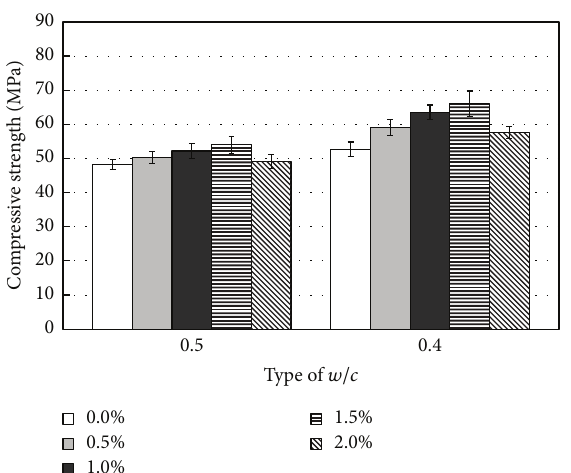
Figure 3: Compressive strength test results of LMHFRCCs.